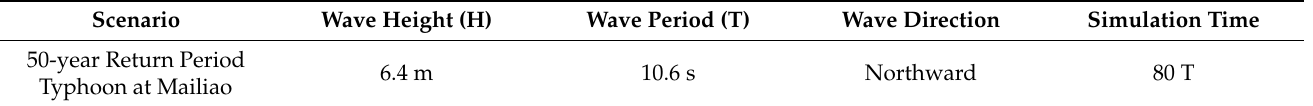
Table 3. FLOW-3D Model Input